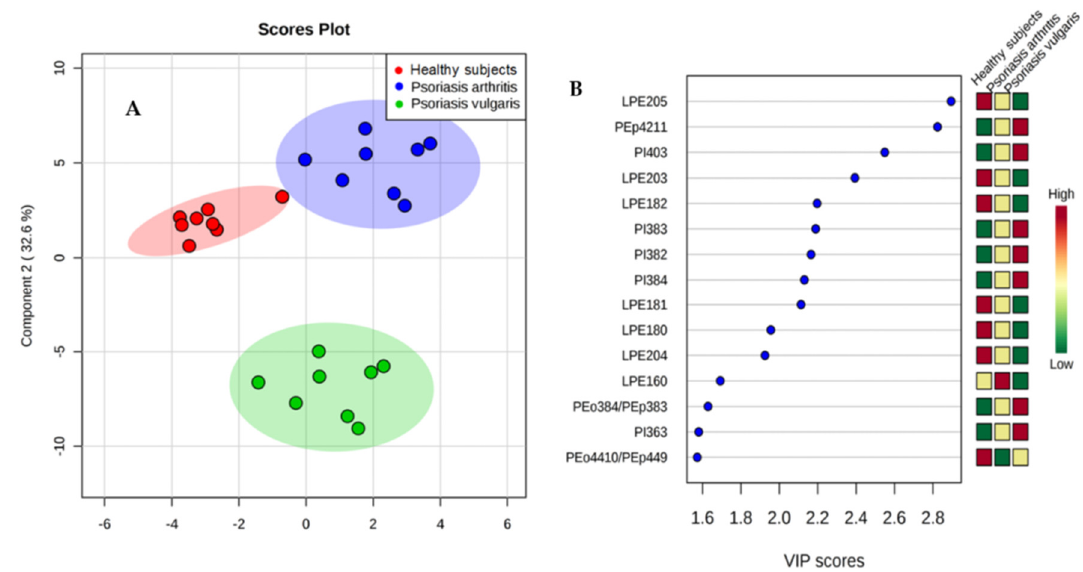
Figure 2. ( A ) Partial least squares-discriminate analysis (PLS-DA) plot of the phospholipid species and relative abundance determined by HILIC-LC-MS in the plasma of healthy people and both groups of psoriatic patients. The red triangles indicate healthy subjects (n = 34) while the green and blue crosses represent patients with psoriasis vulgaris (n = 68) and psoriatic arthritis (n = 34), respectively. ( B ) Graphical presentation of the regulation of phospholipids with VIP score ≥ 1, which differentiate healthy subjects and patients with psoriasis vulgaris and psoriatic arthritis.